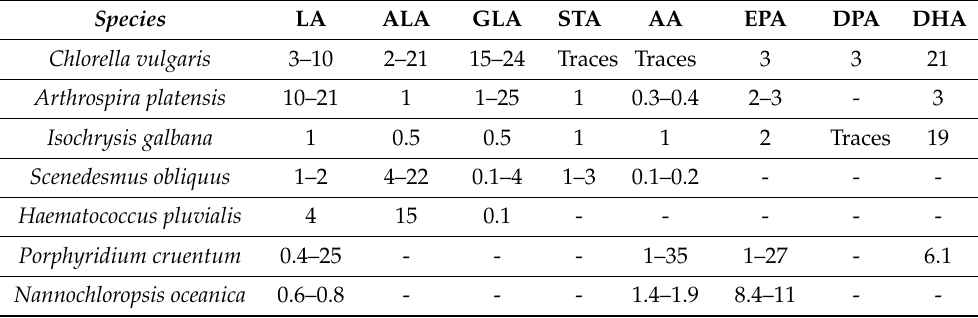
Table 3. Polyunsaturated fatty acids in microalgae (extracted from [17,43]; given in % of total fatty